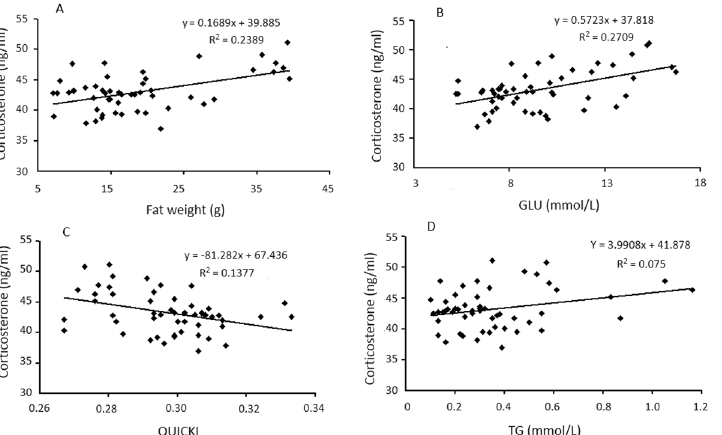
Fig 4. Correlations between serum corticosterone and severalvariables. Analysesindicatedthat corticosterone levels were positivelyassociatedwith fat weights (A. r = 0.500, r 2 = 0.239, P = 0.000), GLU (B. r = 0.520, r 2 = 0.271, P = 0.000), and TG (C. r = 0.274, r 2 = 0.075, P = 0.047), and negatively correlated with QUICKI (D. r = − 0.375, r 2 = 0.138, P = 0.006). Each diamond( ♦ ) represents one animal( n = 53). CS = control diet and sedentary; CME = control diet with ME exercise; CHI = control diet with HI exercise; HS = high-fat diet and sedentary; HME = high-fat diet with ME exercise; HHI = high-fat diet with HI exercise; GLU = glucose; QUICKI = the quantitative insulinsensitivity check index; TG =